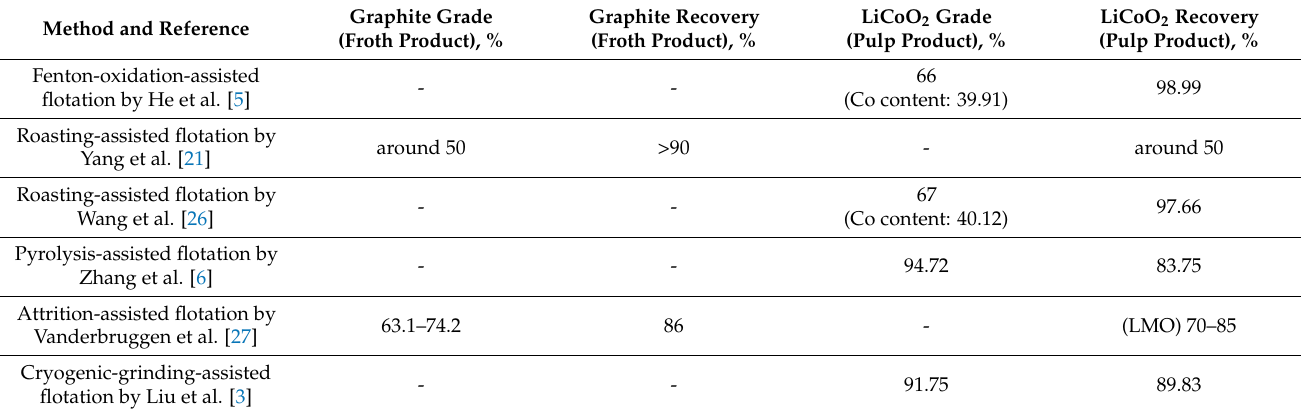
Table 1. Summarized flotation results of recent